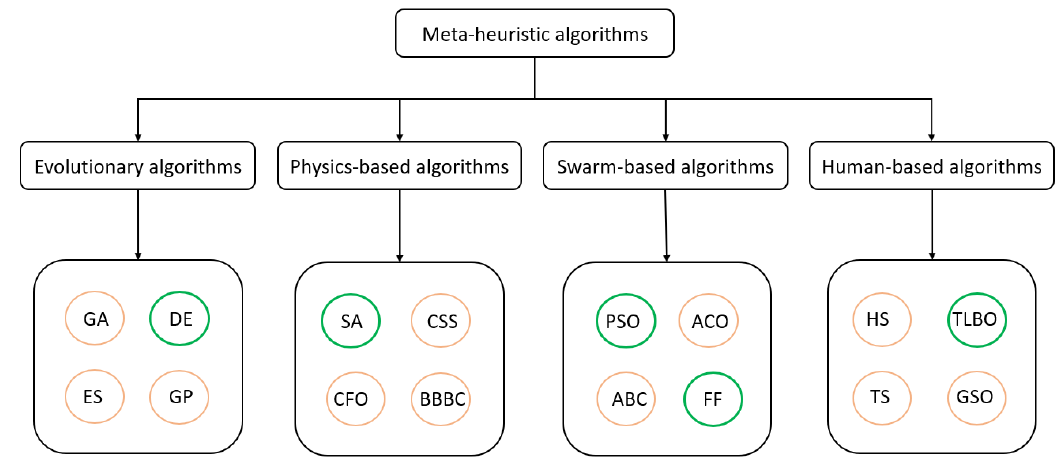
Figure 5. Classification of metaheuristic optimization methods and the selection of used algorithms in this paper (in green circles): Genetic algorithm (GA), differential evolution (DE), evolution strategy (ES), genetic programing (GP), simulated annealing (SA), charged system search (CSS), central force optimization (CFO), big-bang big-crush (BBBC), particle swarm optimization (PSO), ant colony optimization (ACO), artificial bee colony (ABC), firefly (FF) algorithm, harmony search (HS), teaching learning-based optimization (TLBO), tabu search (TS), group search optimizer (GSO).